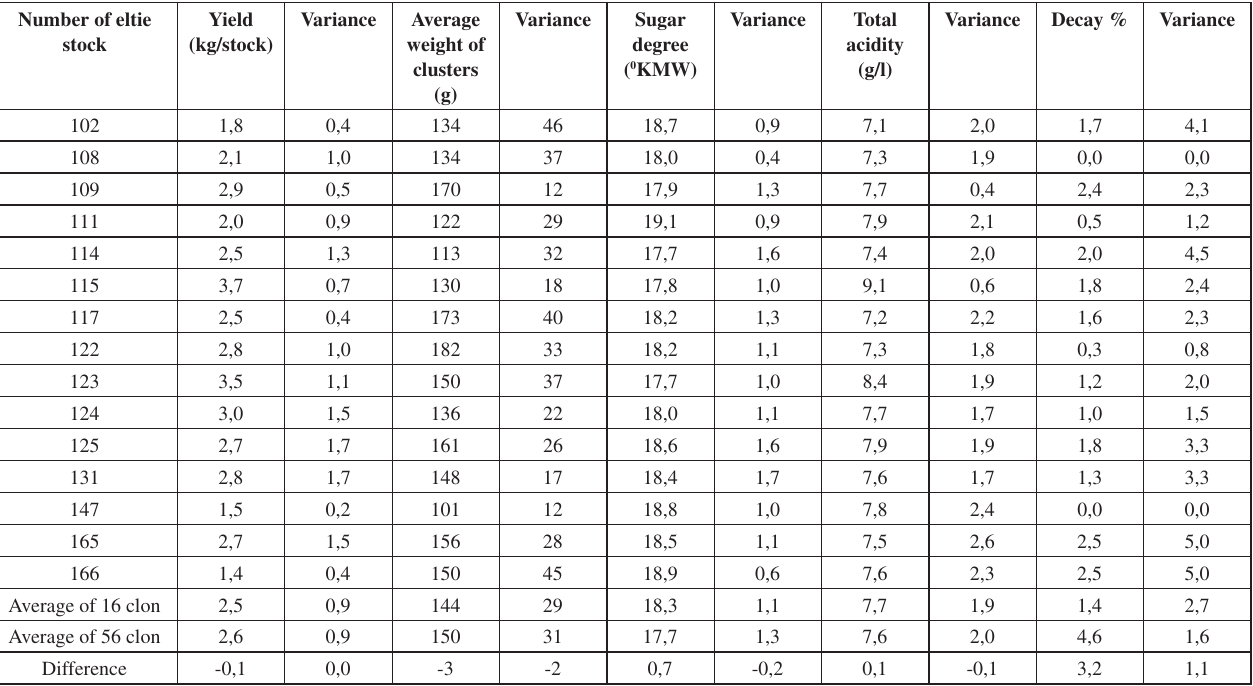
Table 2. Comparison of the data of the 16 best performing ‘Kadarka’ elite stocks with the average values of the 56 ‘Kadarka’ elite stocks (Szekszárd - Parászta field,